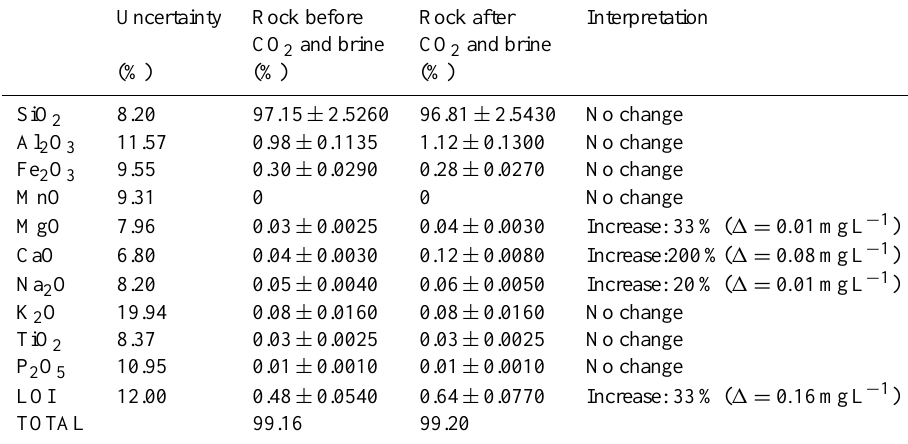
Table 3. Chemical composition of whole rock (Utrillas sandstone) before and after the experiment. Uncertainty given by IGME Laboratory (XRF